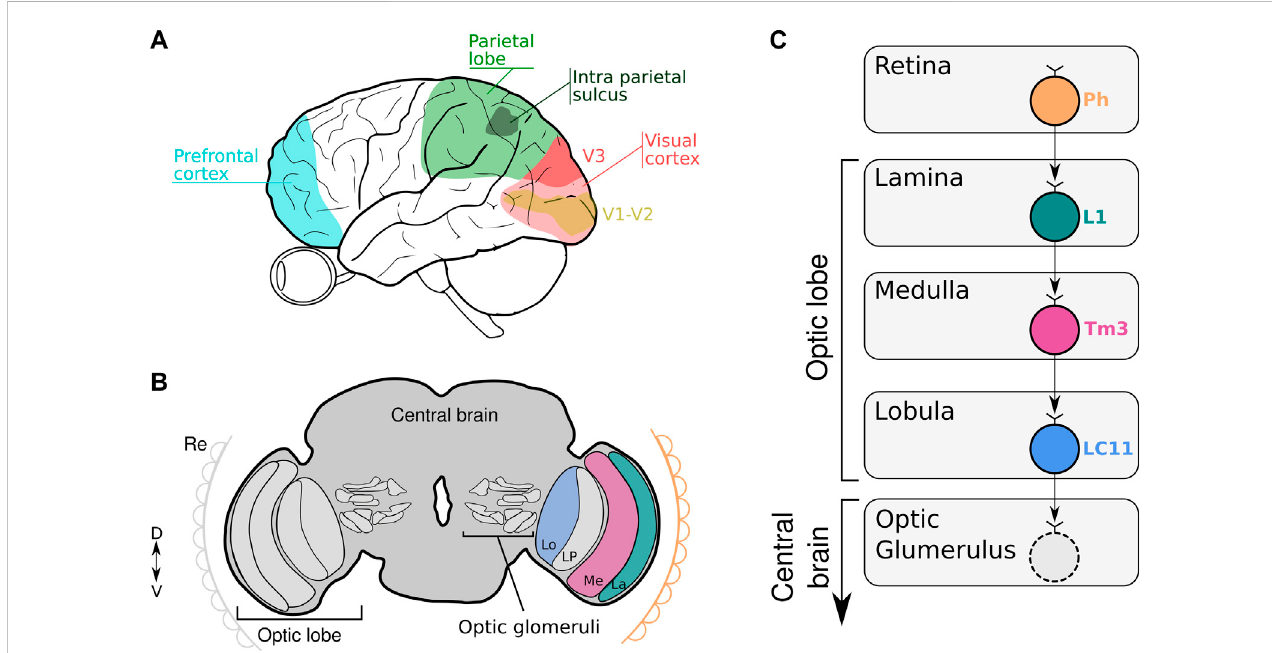
FIGURE 1 (A,B) Theschemeillustratesthelocationofkeyareasofthehuman (A) andfruit fl ybrain (B) involvedinnumericalcodi fi cation. (A) Numericalinformation is captured by the eye and process in the visual cortex, parietal lobe and prefrontal cortex. (B) Numerical information is captured by the retina (Re) and processed in the subsequent optic neuropiles (La: Lamina; Me: Medulla, Lo: Lobula and LP: Lobula Plate) to fi nally reach the central brain where the optic glomeruli are located. (C) Schematic diagram of neural circuits related to LC11 connectivity from the retina down to the different neuropiles within the opticlobe.Visualinformationiscapturedbythephotoreceptors(Ph)intheretinaandtransferredtoL1neuronsinthelamina.Theinformationistransmittedto the Tm3 neurons in the medulla. In the lobula, LC11 neurons collect information from the Tm3 neurons. The optic glomerulus in the central brain receives inputs from LC11 neurons where the signals are transmitted to descending neurons leading to visually-guided